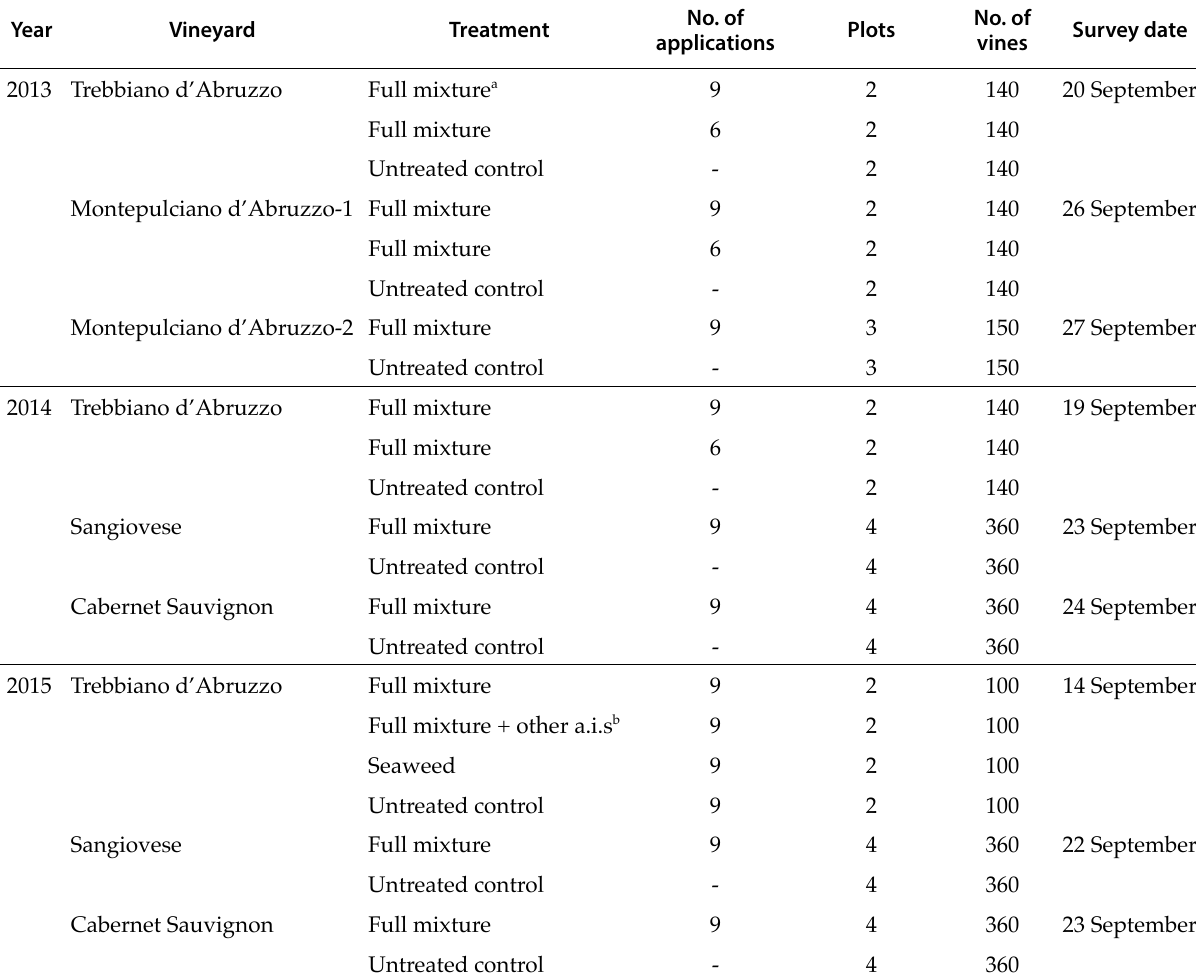
Table 2. Treatment plan applied in five GLSD affected vineyards in